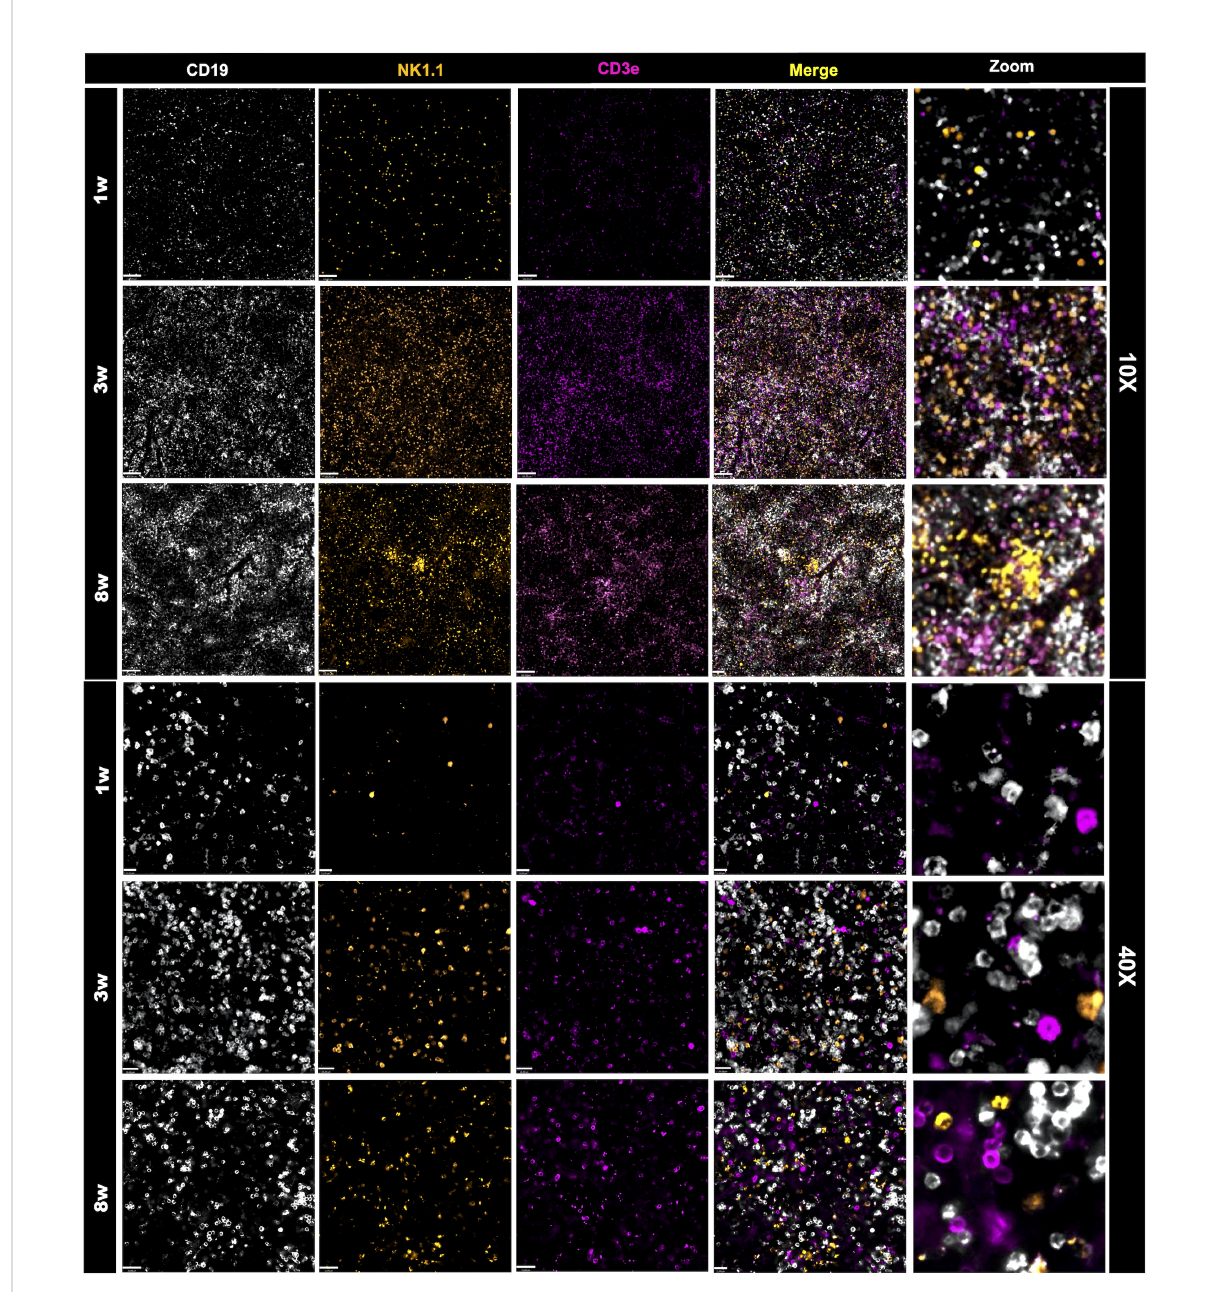
FIGURE 2 Changes in the frequency and organization of the lymphoid splenic compartment. Spleen staining in different ages using WT mice that received an intravenous injection containing anti-CD19 (in white), anti-NK1.1 (in orange) and anti-CD3e (in magenta). Scale bars = 120 m m (10x); 21 m m (40x). Zoom images were enlarged 8